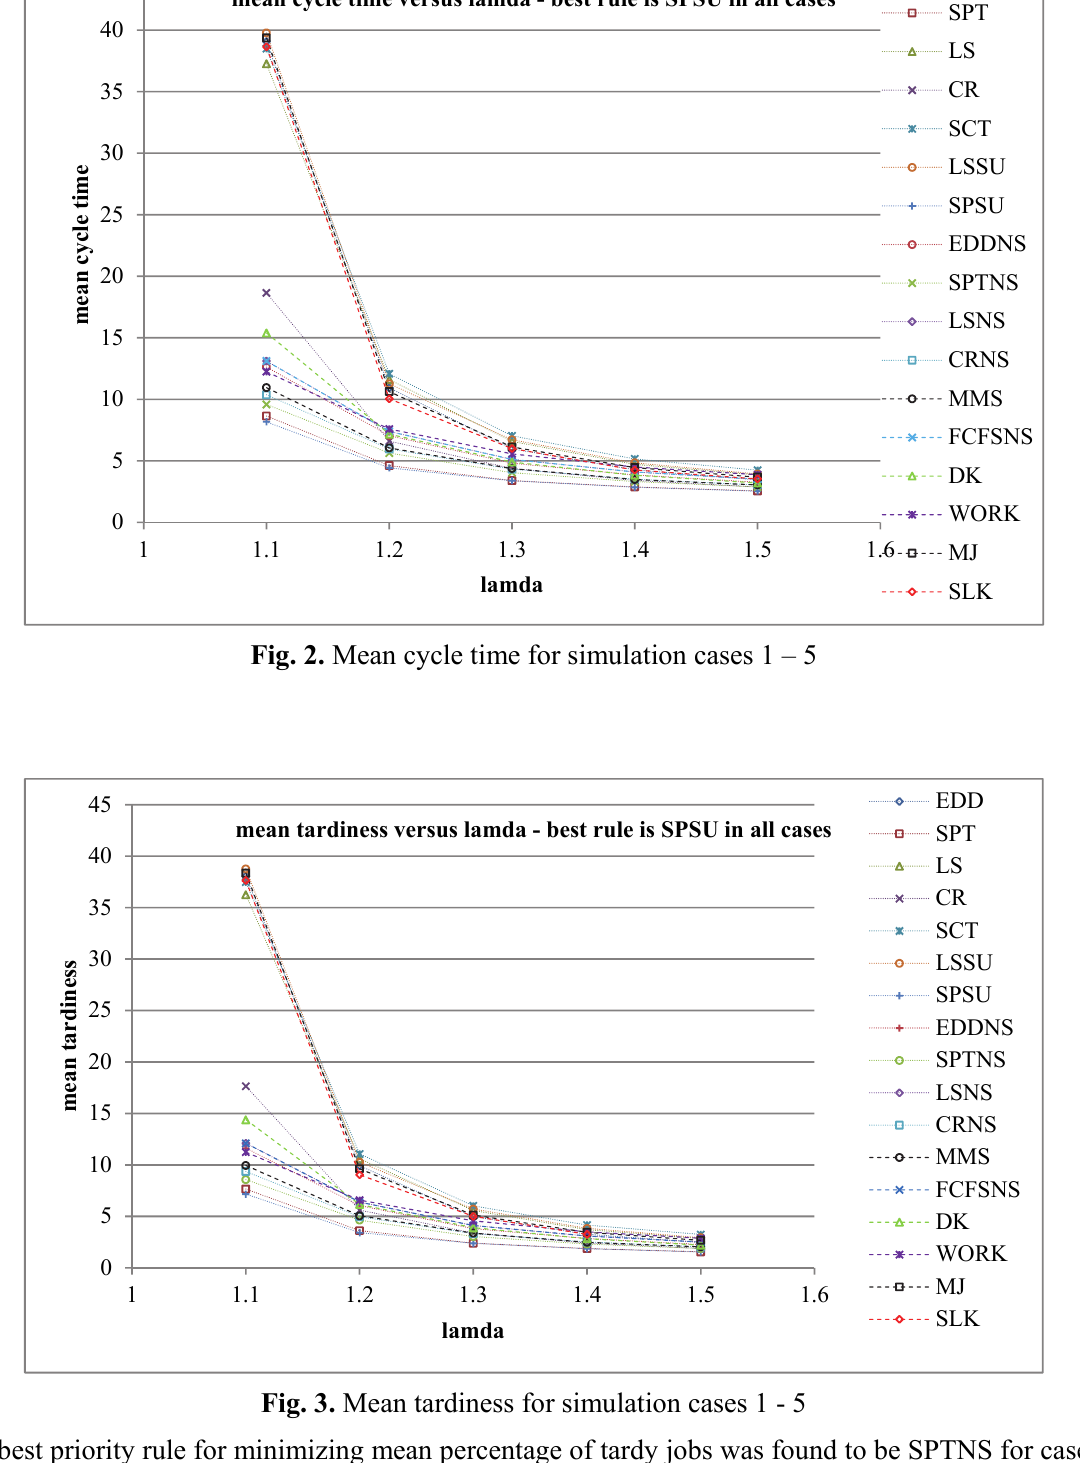
lamda Fig. 3. Mean tardiness for simulation cases 1 - 5